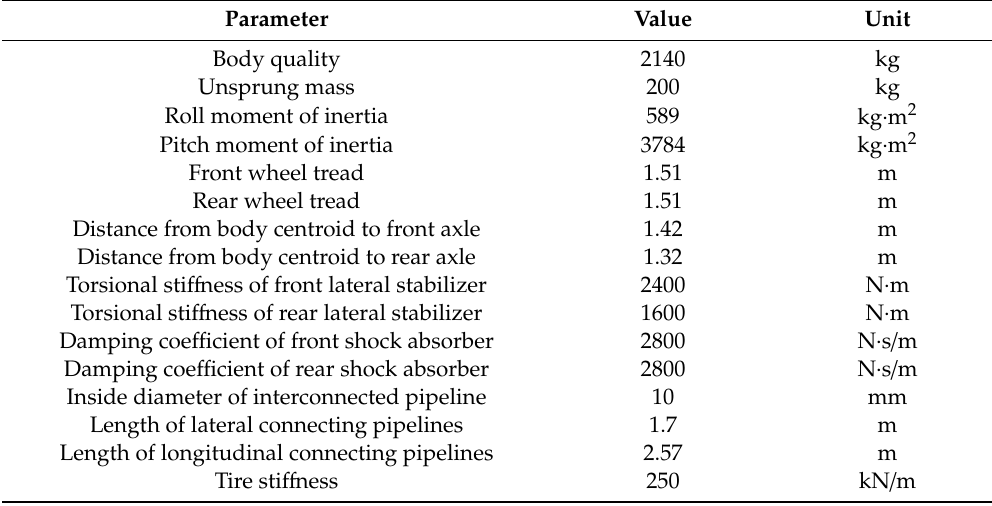
Table 2. Vehicle model parameters.